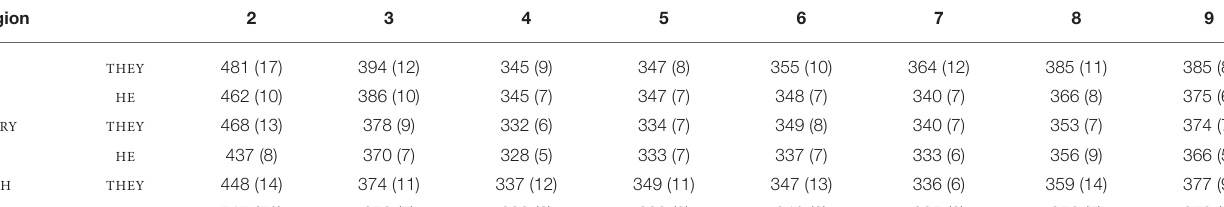
TABLE 4 | Mean raw reading times (SE) in ms, Experiment 3. Region